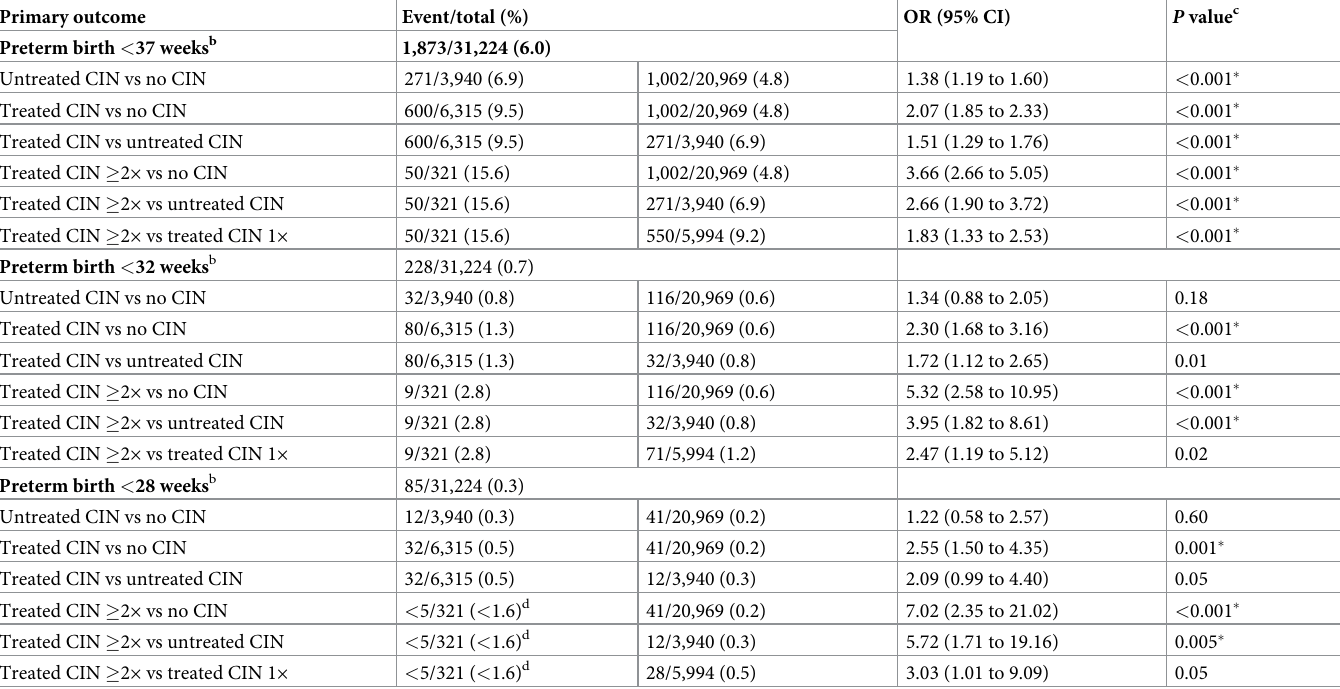
Table 2. Multivariable logistic regression for preterm birth for women with no CIN, untreated CIN, and treated CIN before each childbirth a .